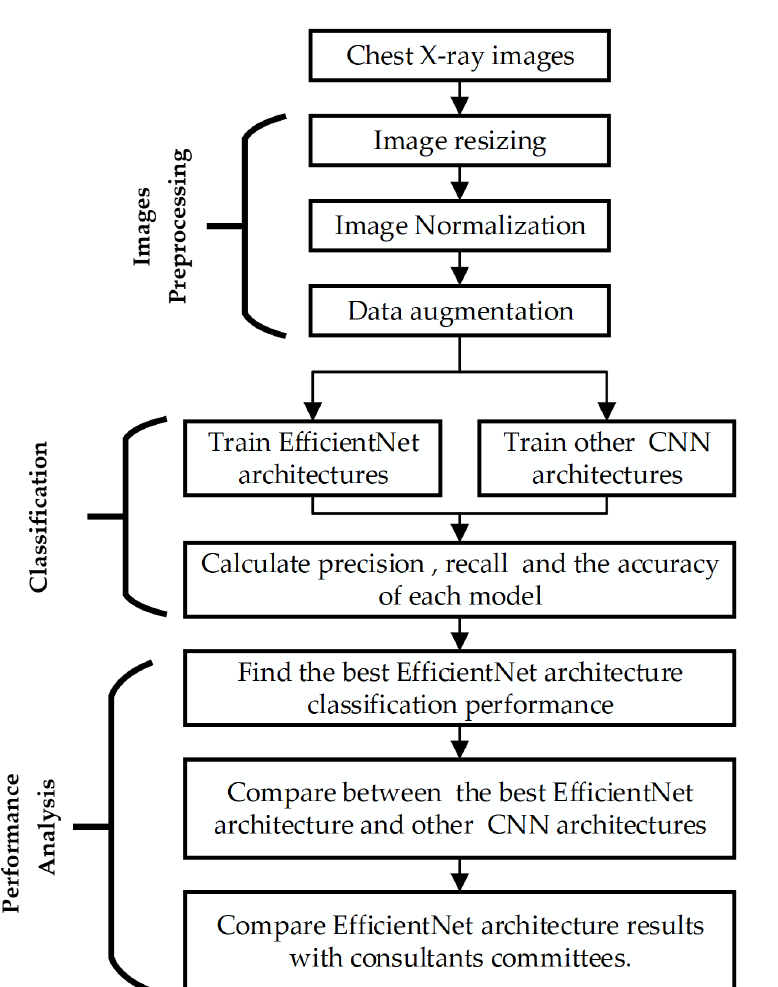
Figure 7. The general methodology for X-ray image classification employing a deep learning